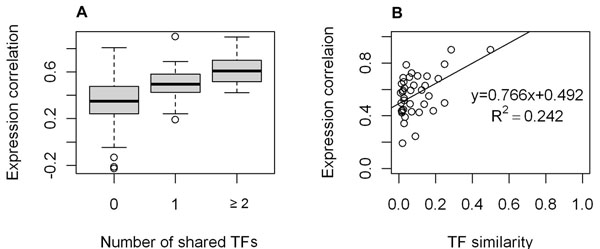
TF similarity is positively related with expression correlation of h2h gene pairs. (A) boxplots of expression correlation values of four h2h pair groups with different level of TF similarities. Pairs sharing at least one TF ( 2nd and 3rd ) boxplots displayed a significantly higher expression correlation than those with no common TF (1st boxplot): mean values 0.564 vs. 0.355, two group t-test p =1.21e-09; pairs sharing two or more TFs (3rd boxplot) displayed a significantly higher expression correlation than those with only one common TF (2nd boxplot): mean values 0.619 vs 0.496., two group t-test p=0.02.(B) the scatter plot of expression correlation values vs. TF similarities (defined as the fraction of shared TFs in the union TFs).